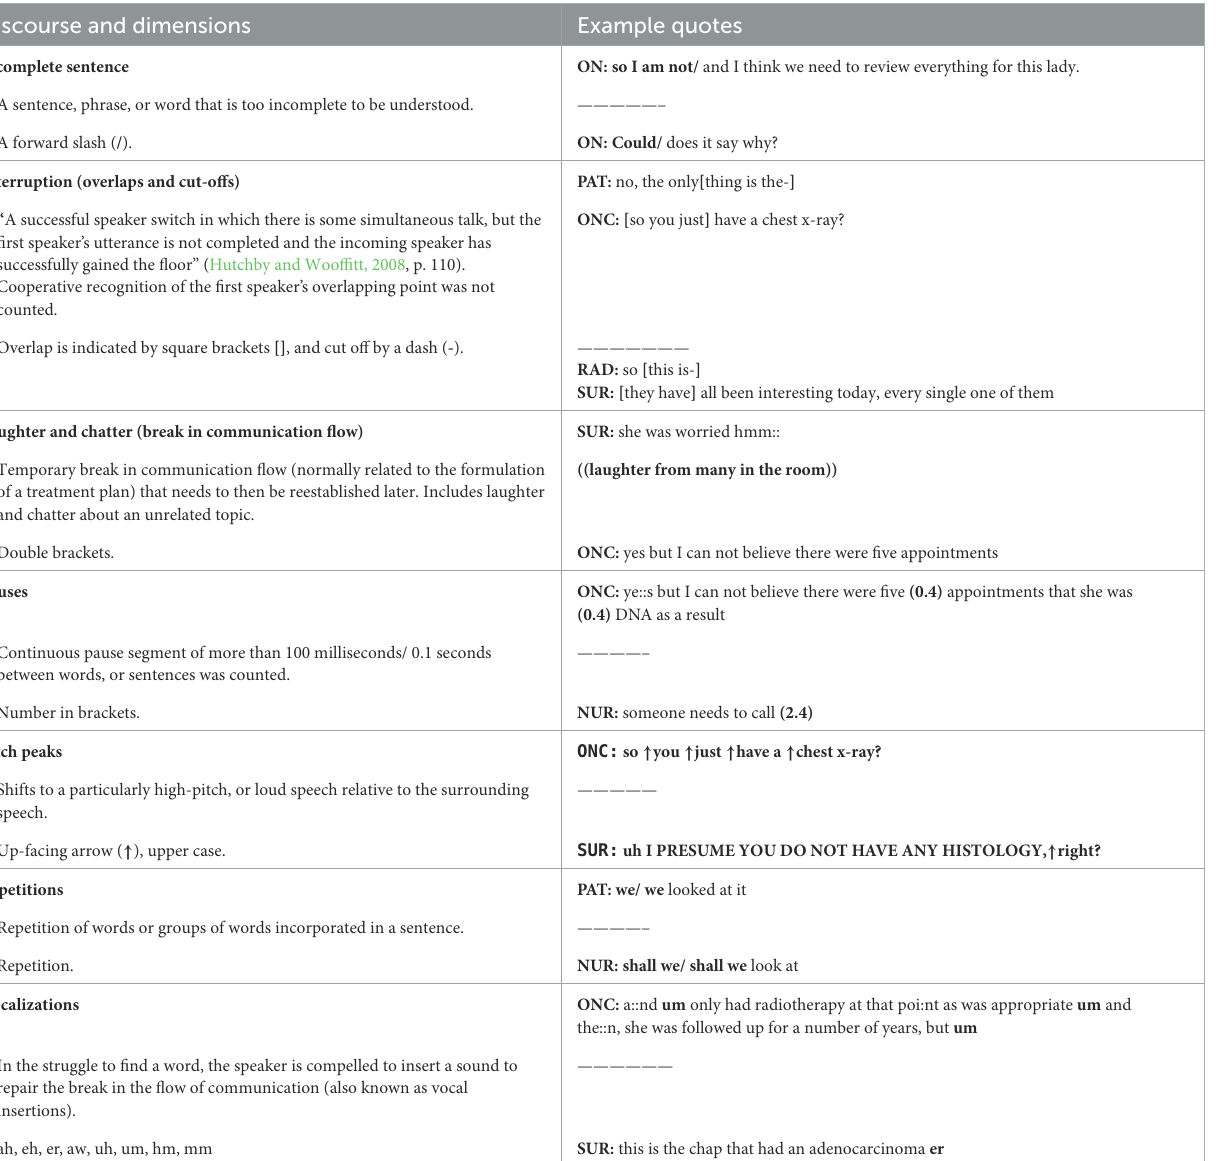
TABLE 3 List of verbal fragmentations, and corresponding definitions, Jefferson notation symbols, and data